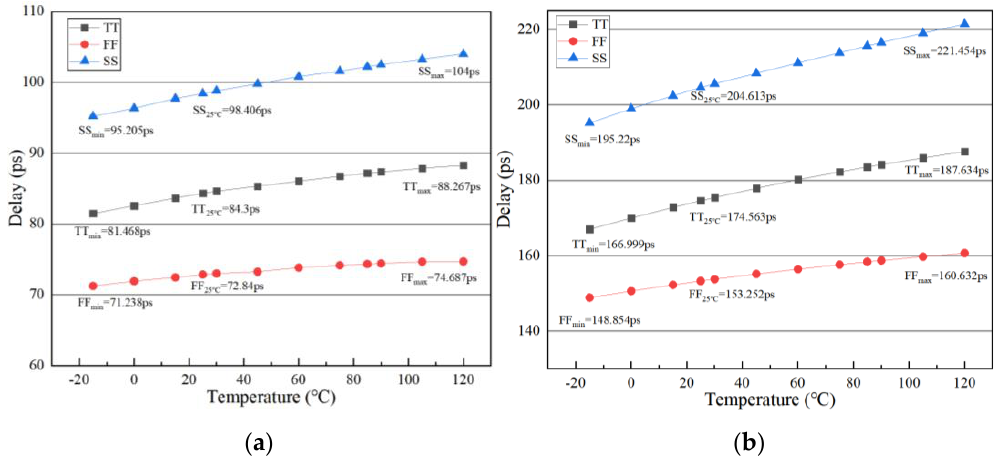
Figure 11. The delay variations of a single delay unit ( a ) OUT_DLL<6:0> = 7′b0000000 ; ( b ) OUT_DLL<6:0> = 7′b1111111 .